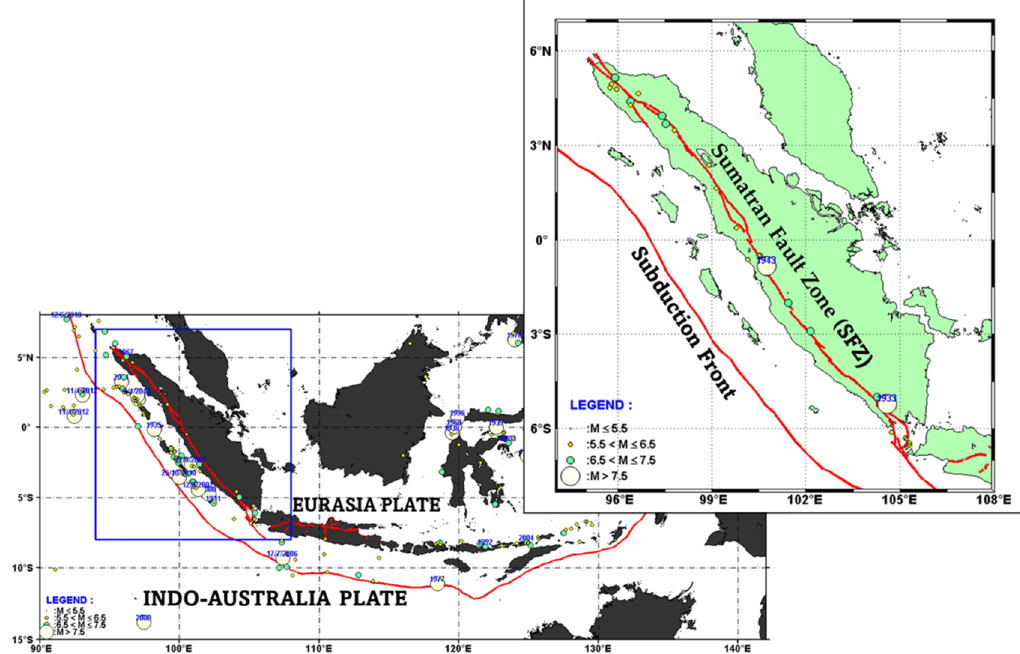
Figure 1. The Sumatran seismotectonic map depicting the Sumatran Subduction Zone and Sumatran Fault Zone (SFZ) overlays with the historical shallow large earthquake data of 1925–2014 with a magnitude (M w ) larger than or equal to 6.0. Historical earthquake data are based on Ref. [9].